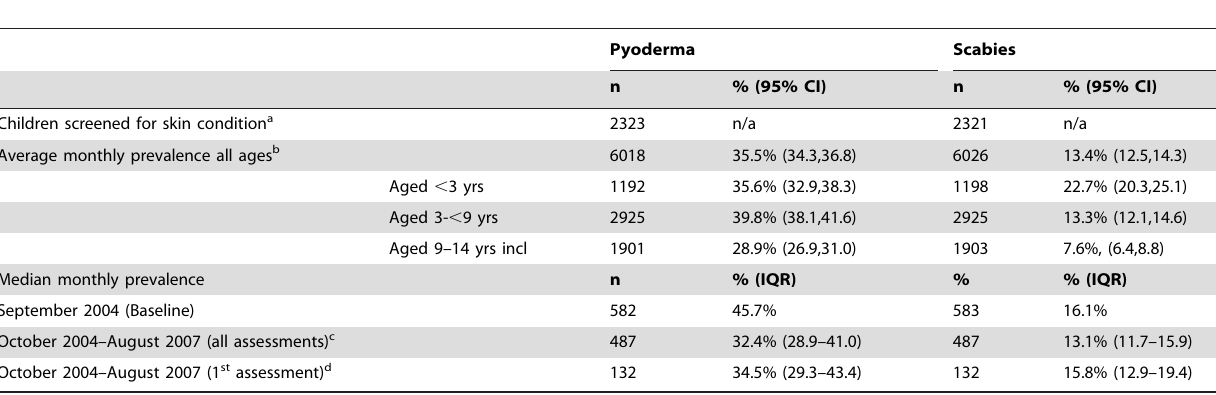
Table 1. Population-based screening for pyoderma and scabies among children aged , 15 years, East Arnhem Region, September 2004–August